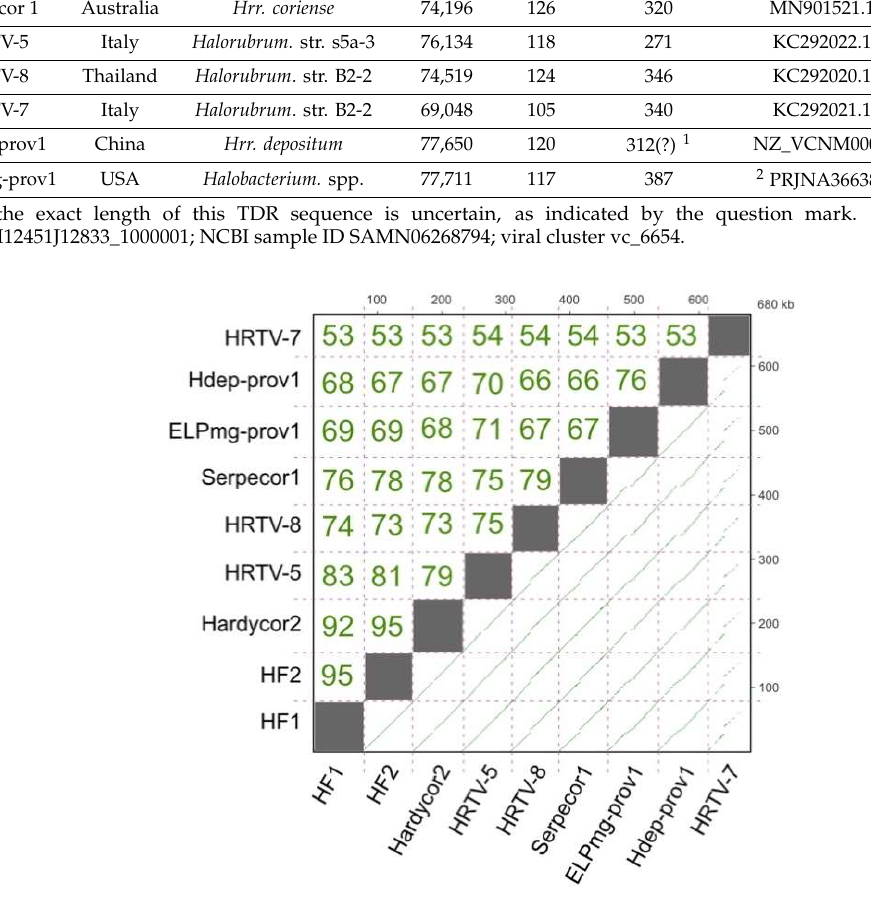
Figure 2. Nucleotide similarity between the genomes of Serpecor1, Hardycor2 and the HF1-group of viruses, including proviruses Hdep-prov1 and ELPmg-prov1. The lower right triangle shows the dot plots of DNA sequence similarity using the Yass aligner [15], where green lines show similarity at a BLASTn E -value setting of ≤ 10 −20 ). The cumulative length of DNA is shown by the scales on the right and upper axes, in kb. Upper triangle shows the pairwise similarity values (percentage of identical nucleotides) after multiple alignment of all genomes using the MUSCLE aligner option within Geneious.